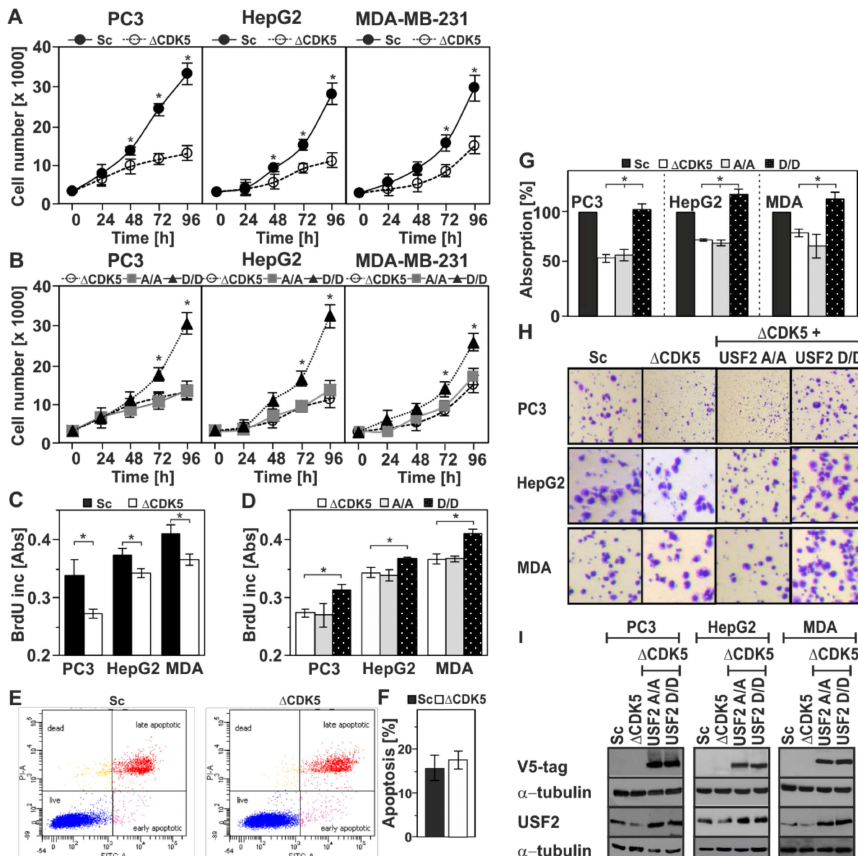
Figure 5. Phosphorylation of USF2 by CDK5 a ff ects cell proliferation and migration. Cellular proliferation was monitored by cell number ( A , B ) and BrdU incorporation ( C , D ) in Sc and ∆ CDK5 cells ( A , C ) and in ∆ CDK5 cells expressing either non-phosphorylatable USF2-S155A / S222A or phosphomimetic USF2-S155D / S222D double mutants ( B , D ). ( E , F ) Apoptosis in Sc and ∆ CDK5 PC3 cells was assessed by Anexin-V / PI staining and analyzed by flow cytometry; ( G ) Migration was assessed by crystal violet staining. The values represent the absorbance of crystal violet at 595 nm. *, significant di ff erence, p ≤ 0.05. ( H ) Representative images of a Transwell migration assay. ( I ) The expression of USF2 was controlled by western blot with an antibody against V5-tag and USF2; α -tubulin served as a loading